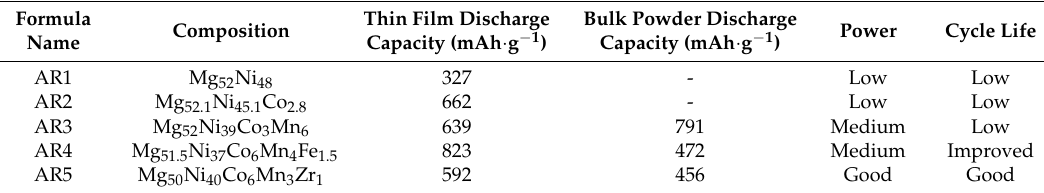
Table 3. Evolution of an MgNi-based MH alloy formula with increasing degree of disorder (number of constituent elements). Bulk powder was produced by melt spinning (MS) + mechanical alloying MA.